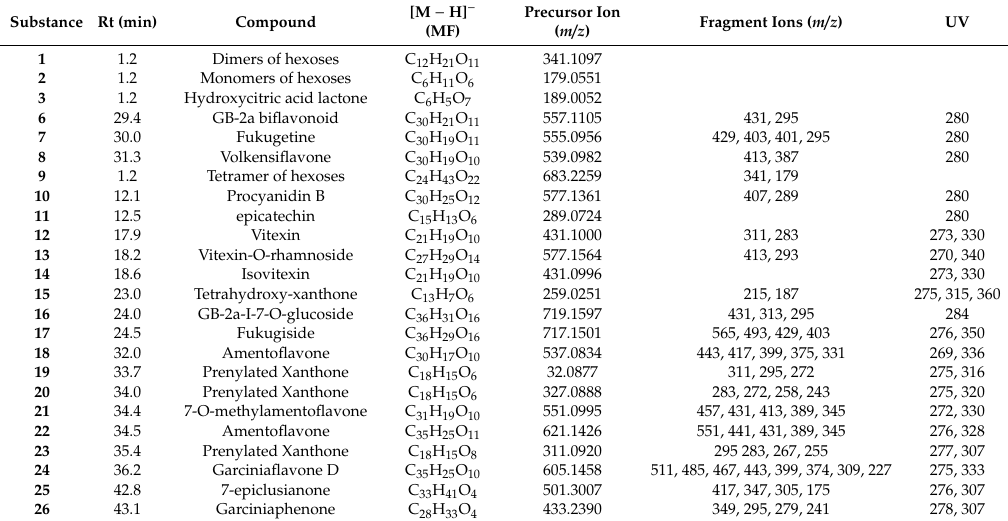
Table 2. Compounds tentatively identified from the ethanol extract of Garcinia gardneriana leaves (EEL). Substance Rt (min)